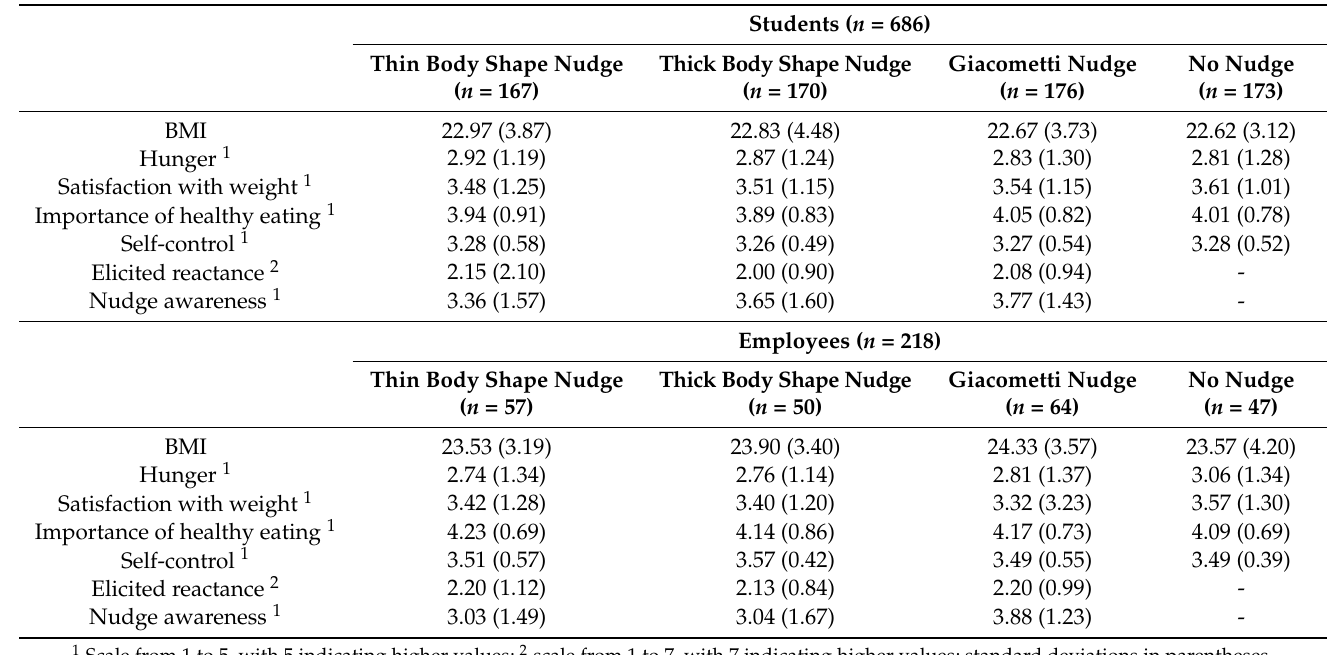
Table 1. Participant characteristics per nudge condition for students and